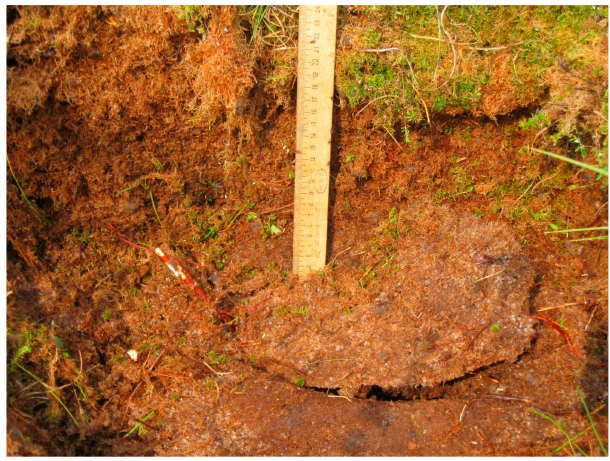
Figure 8. Peat-permafrost soil in a stream